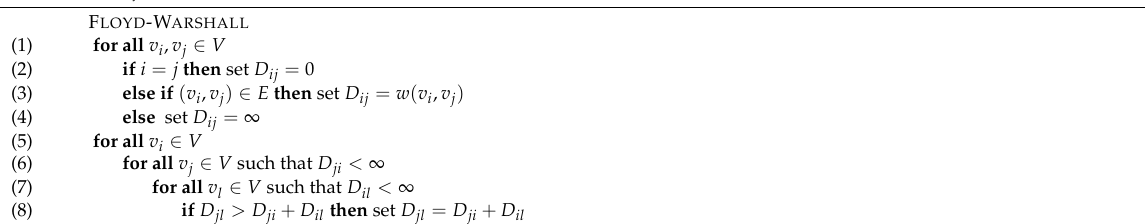
Algorithm 2 The Floyd–Warshall algorithm for calculating the shortest distance D ij between each pair of vertices v i , v j ∈ V